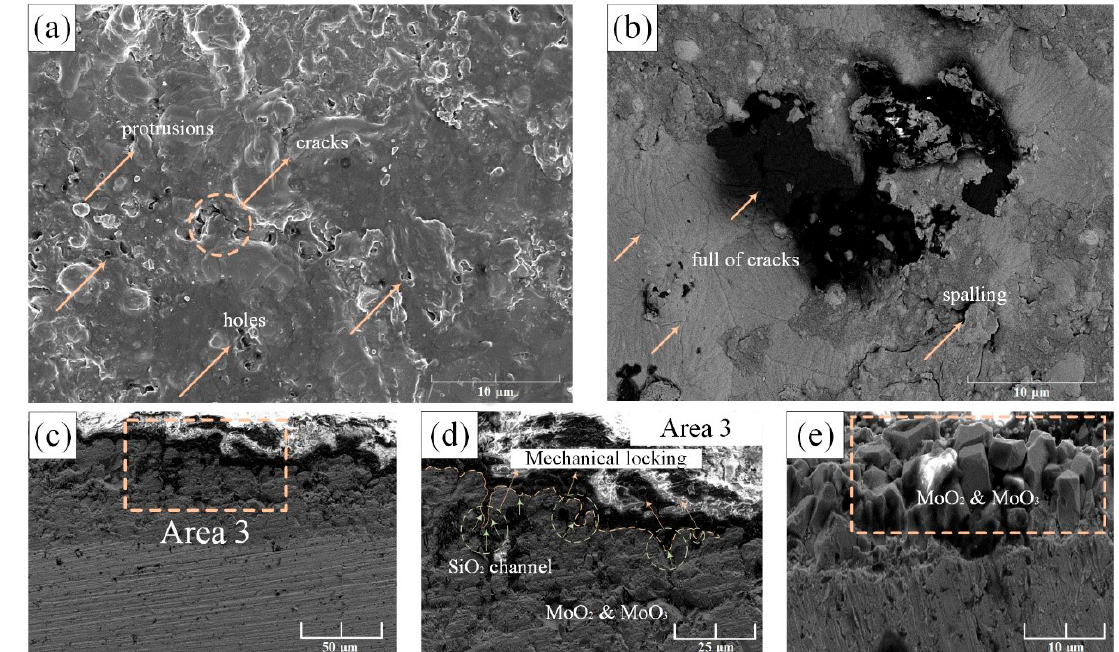
Figure 5. SEM microstructures of pre-oxidized Mo-9Si-8B composite after oxidation in air at 1150 ◦ C for 50 h: ( a , b ) are surface SEM images of the alloy; ( c ) cross-sectional morphology of the edge; ( d ) local magnification of area 3 in ( a ); ( e ) molybdenum oxide products grown from the substrate.